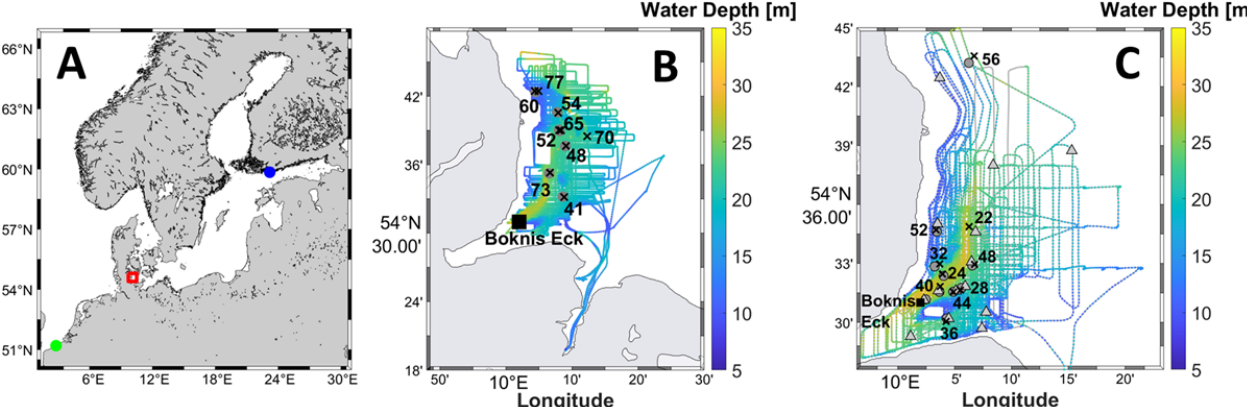
Figure 1. (a) Overview map of the Baltic Sea and the southeastern North Sea. The red square marks the research area of this study in the Kiel Bight. The green and blue circles mark the sampling sites of Borges et al. (2019) and Humborg et al. (2019), respectively. (b) Cruise track of cruise AL510 in June 2018. (c) Cruise track of cruise AL516 in September 2018. The black crosses mark CTD stations, dark grey dots mark zodiac sampling sites, and light grey triangles mark UW sampling sites. The maps were computed using the m_map toolbox in MATLAB (Pawlowicz,